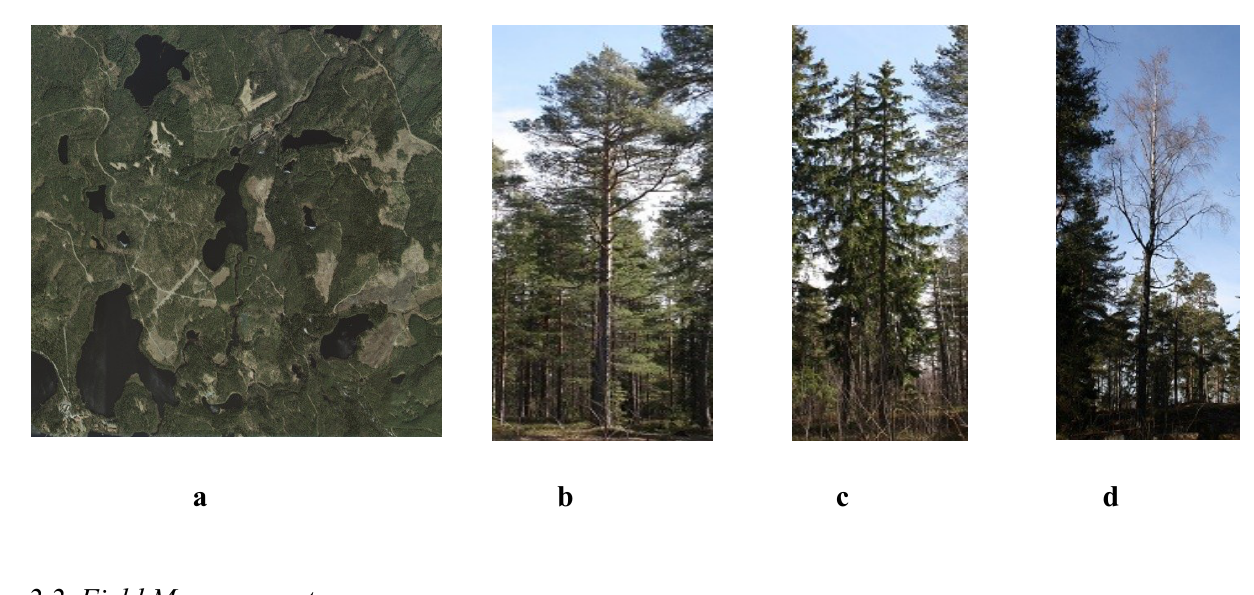
( d ) a birch; photos were taken at the different date than ALS (Airborne Laser Scanning) acquisition.